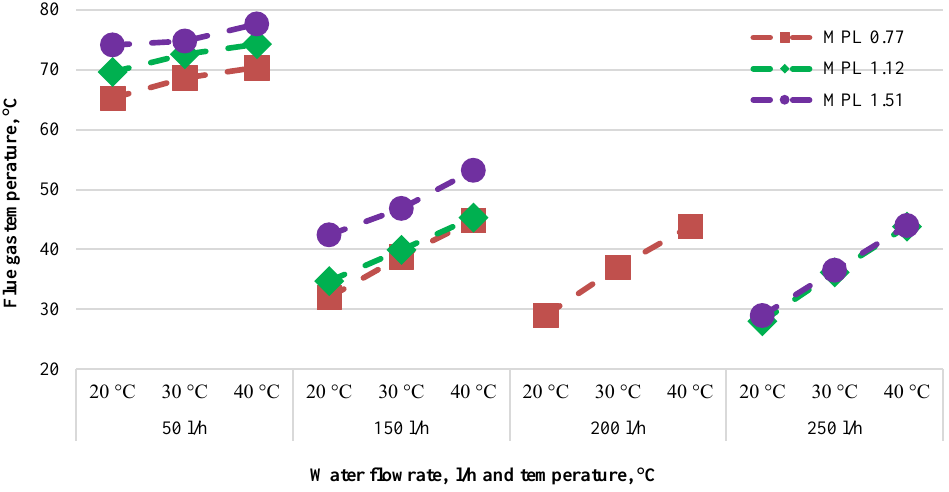
Fig. 1. Effects of nozzle size, sprayed water flowrate and temperature on flue gas temperature after the fog unit. It is observed, that at similar water flowrate and temperature the flue gas temperature strongly varies depending on the nozzle used. The reason is difference in sprayed water drop size, which varies from 199 to 314 μm for MPL0.77 M, from 204 to 459 μm for MPL1.12 M and from 274 to 788 μm for MPL1.51 M. The biggest effect of the nozzle was determined at low flowrate – 50 l/h, where, depending on the type of nozzle, flue gas temperature varies at a range from 6.1 to 8.9 °C at similar temperature. The main reason is the higher difference between sprayed water drop sizes. At high flowrate (250 l/h) the difference between sprayed water drop sizes is lower (204 μm for MPL1.12 M and 274 μm for MPL1.51 M), therefore difference of flue gas temperature after the fog unit is low. The lowest temperature decrease of flue gas was achieved using nozzle MPL1.51 M. It shows that using small drop sizes leads to deeper flue gas